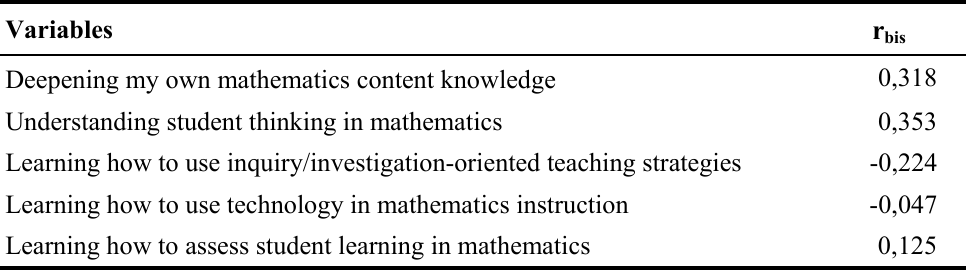
Table 9 : Correlation between students’ achievement and professional development activities